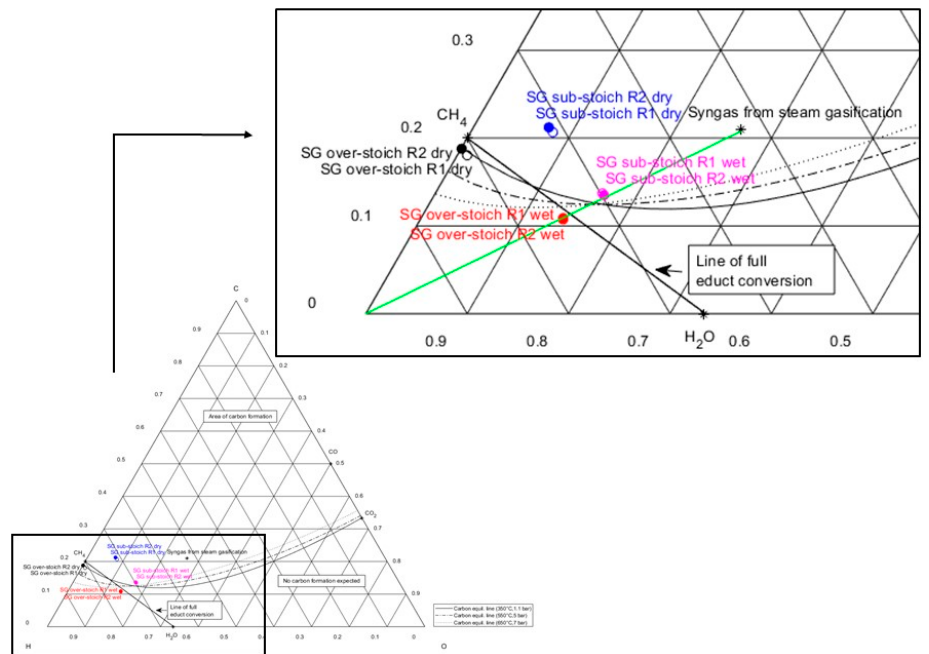
Figure 7. Ternary C ‐ H ‐ O ratio diagram showing wet and dry intermediate and product gas compo ‐ sitions (after first and second stages, R1 and R2) of syngas methanation from steam gasification under sub ‐ stoichiometric and over ‐ stoichiometric hydrogen